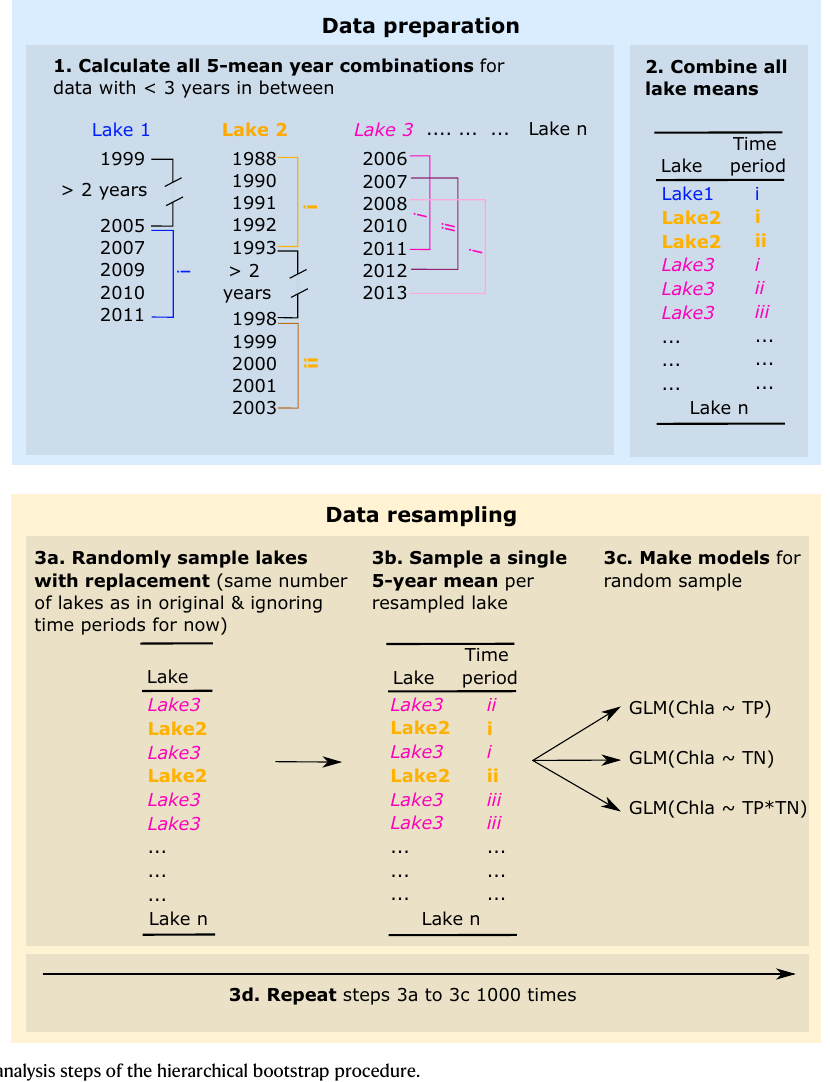
Fig. 4 | Data preparation and analysis steps of the hierarchical bootstrap